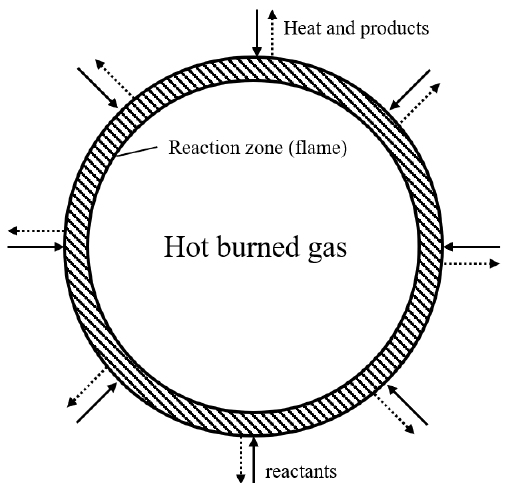
Figure 9. Flame ball configuration. The outward arrows represent the diffusion of heat and products; the inward arrows represent the diffusion of reactants.